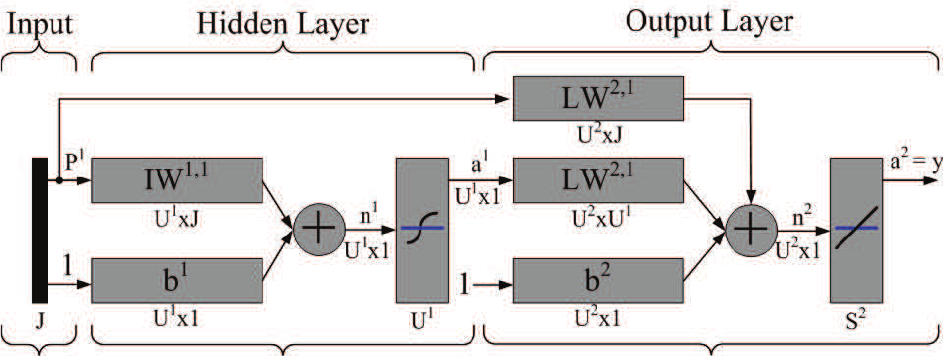
Figure 4. The three-layer perception network architecture for analyzing the performance of the